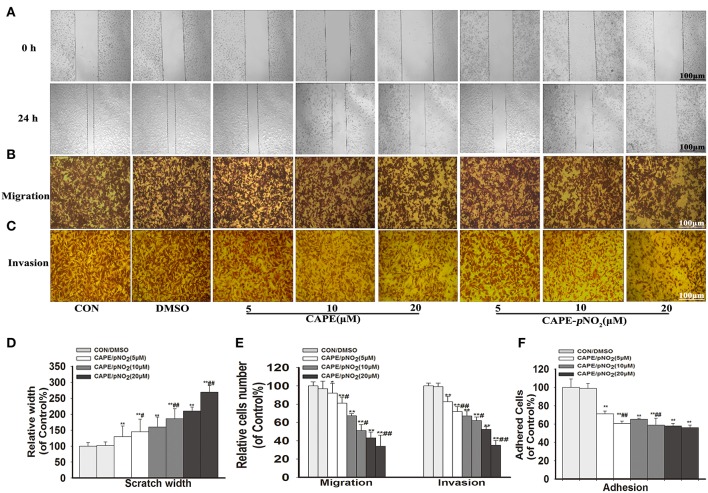
CAPE-pNO2 inhibited cell migration, invasion and adhesion abilities in vitro. MDA-MB-231 cells were incubated with CAPE or CAPE-pNO2 (5, 10, and 20 μM) for 24 h. (A) Migration ability was analyzed using a wound healing assay. (B,C) The cell migration and invasion abilities were analyzed using a Transwell assay. (D,E) A graphical representation of quantitative data showing the relative width of wound healing and the number of migrated and invaded cells. The data were analyzed by Image-Pro Plus software. (F) The cell adhesion ability was analyzed by an adhesion assay, and cells were incubated with CAPE or CAPE-pNO2 (5, 10, and 20 μM) for 2 h. Values represent the mean ± SD from three independent experiments; *p < 0.05, **p < 0.01: DMSO, CAPE and CAPE-pNO2 compared with the control; #p<0.05, ##p<0.01: CAPE-pNO2 compared with CAPE at the same concentration.